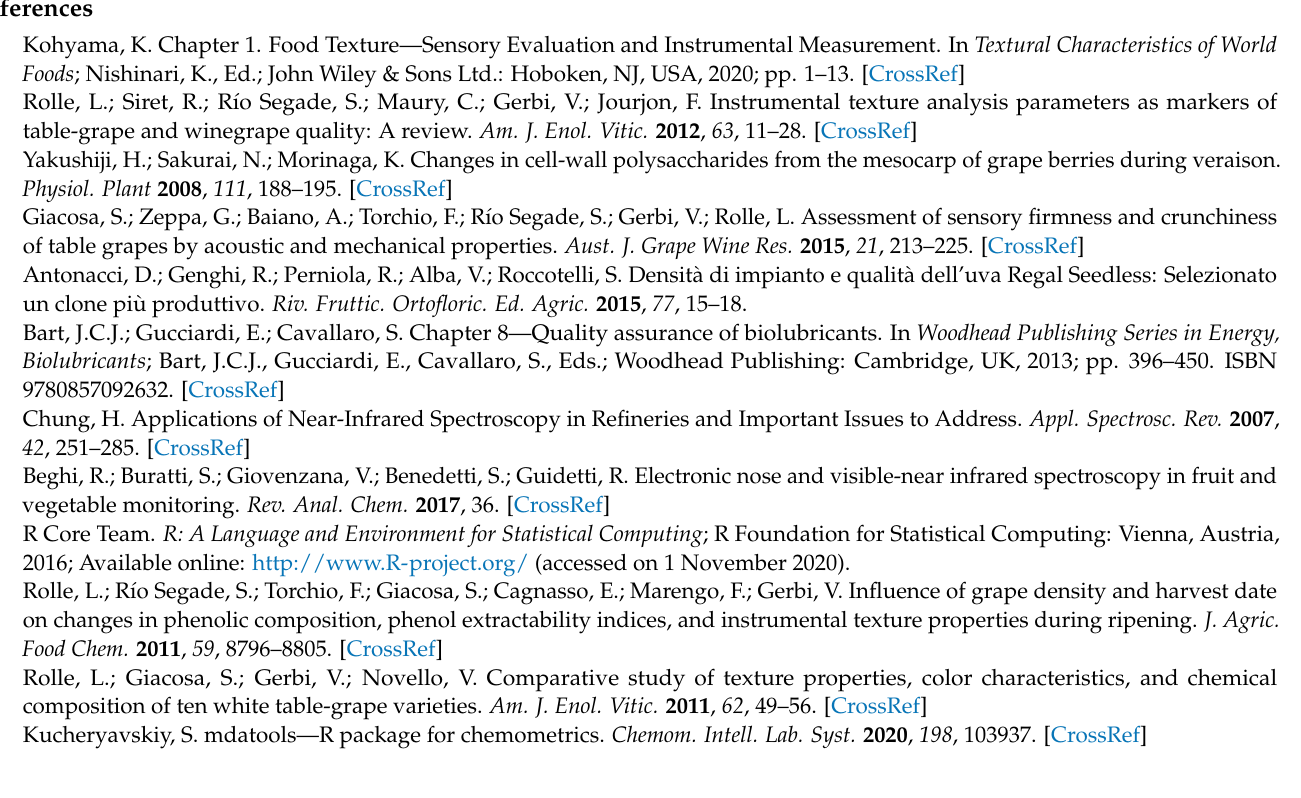
Table S2. Instrumental texture analysis and TSS parameters. Table S3. Regression